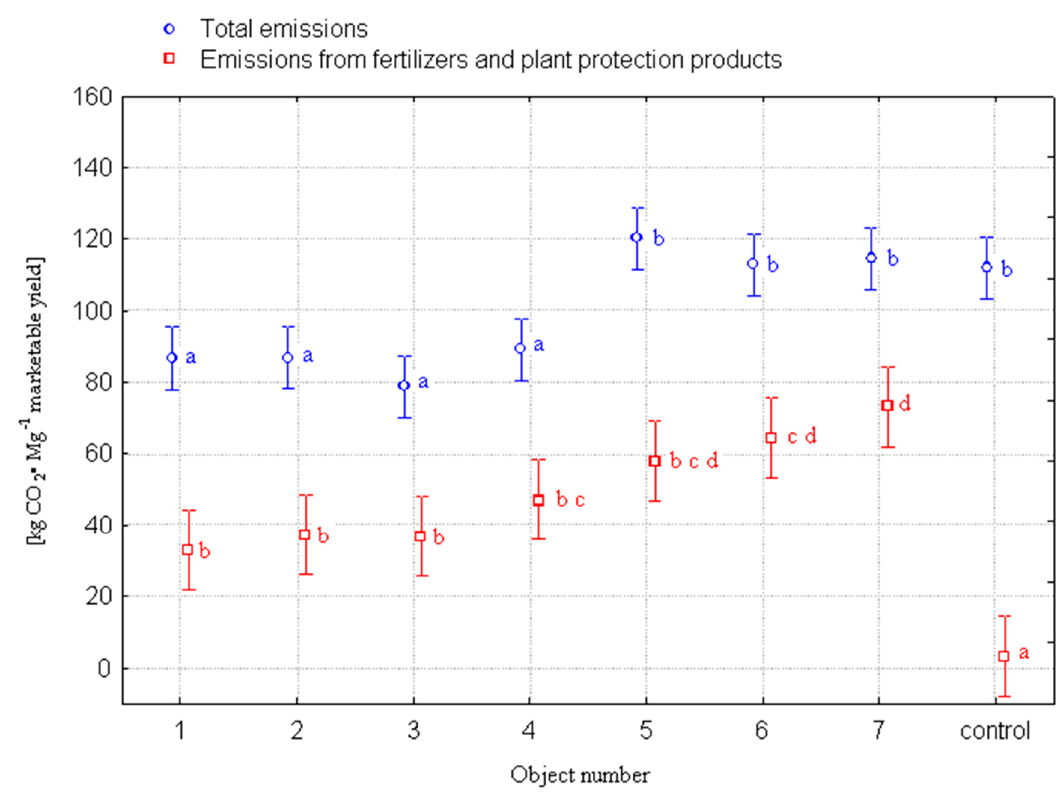
Figure 2. Total GHG emissions and emissions related to the use of fertilizers